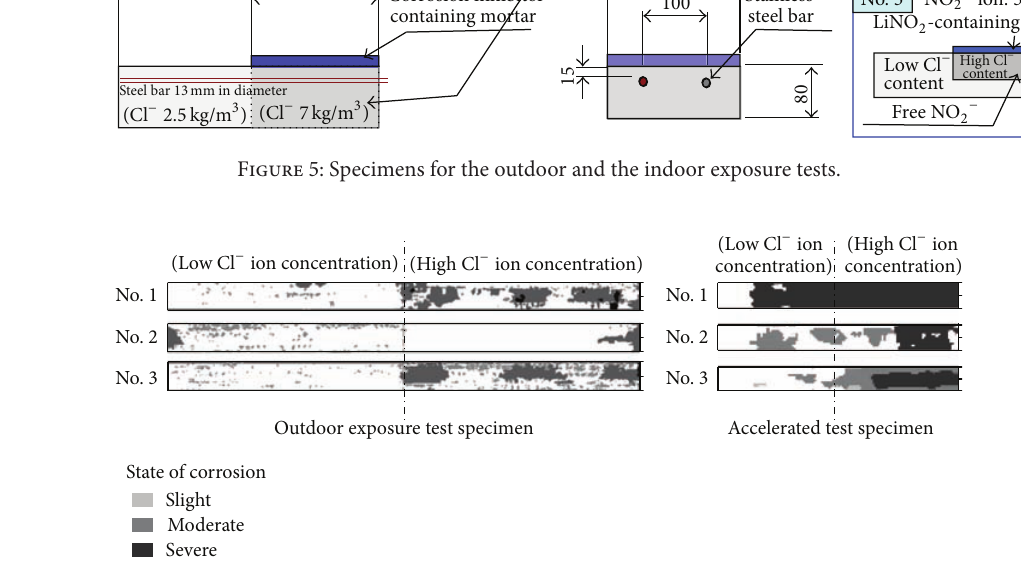
Figure 6: States of corrosion on steel bars after the completion of exposure